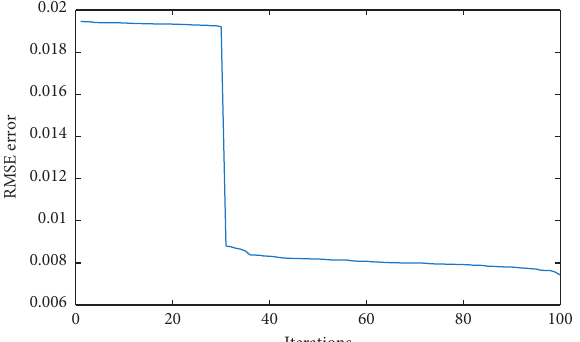
Figure 6: The variation of RMSE with the number of iterations.